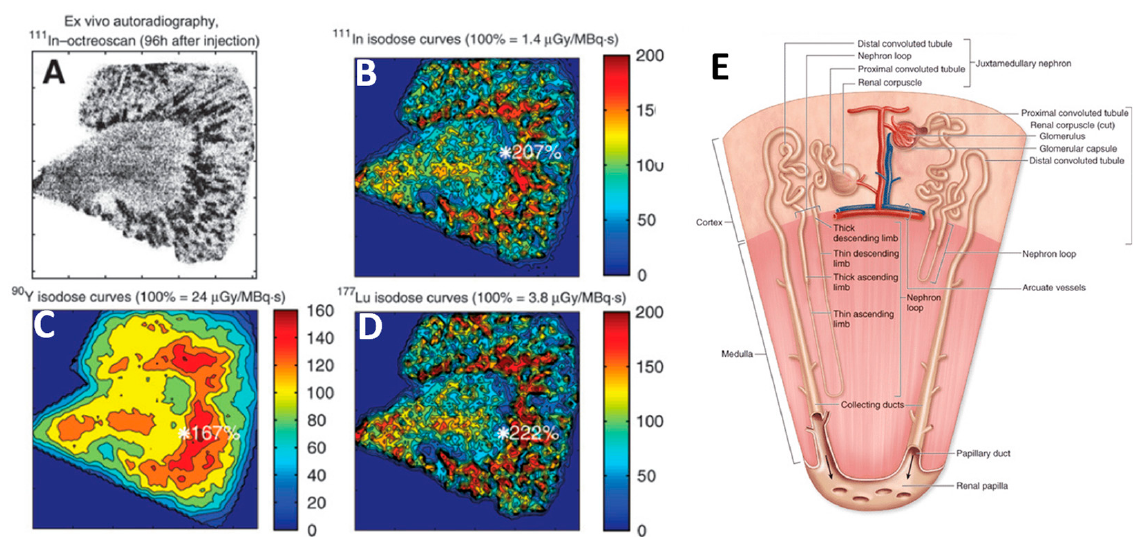
Figure 2. ( A ) 111 In autoradiography. ( B – D ) corresponding isodoses simulated by Monte Carlo for 111 In, 90 Y and 177 Lu, respectively. Reprinted with permission [21] 2021 SNM. ( E ) nephron anatomy showing the glomerulus and tubule location. Reprinted from [22].